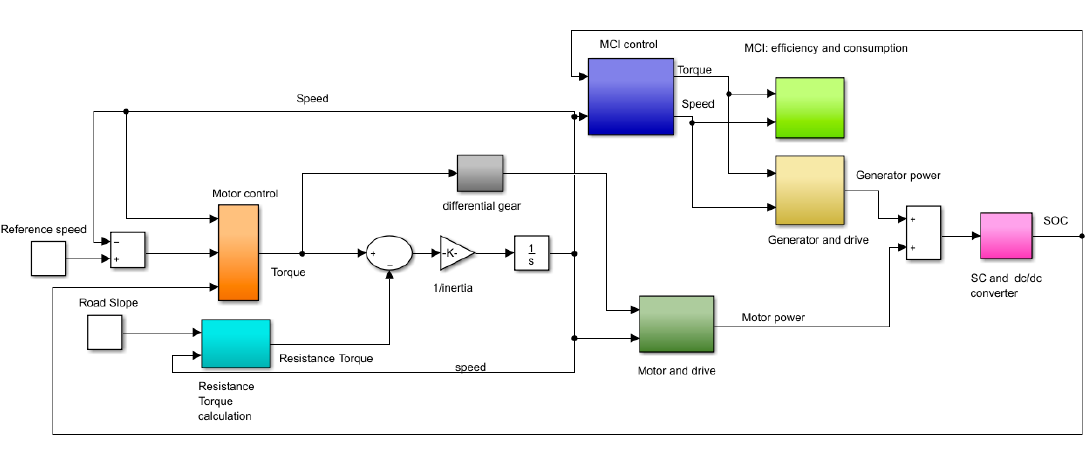
Figure 10. Hybrid powertrain MATLAB Simulink model.